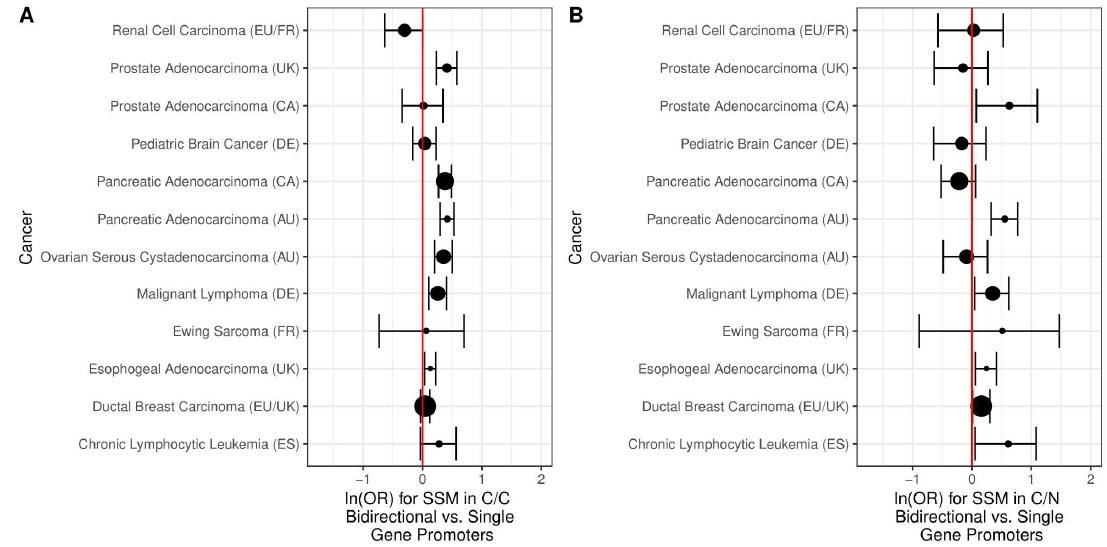
Figure 4. The log odds of simple somatic mutations in bidirectional vs. single gene promoters. The size of the points indicates the relative sample size and 95% confidence intervals are shown. ( A ) For C/C bidirectional promoters, there were somewhat higher odds of SSMs compared to single gene promoters for most cancers (the only exception was renal cell carcinoma). These results were statistically significant in six of the datasets; ( B ) For C/N bidirectional promoters, there were higher odds of SSMs in 7 of the 12 datasets and 6 of these were statistically significant.